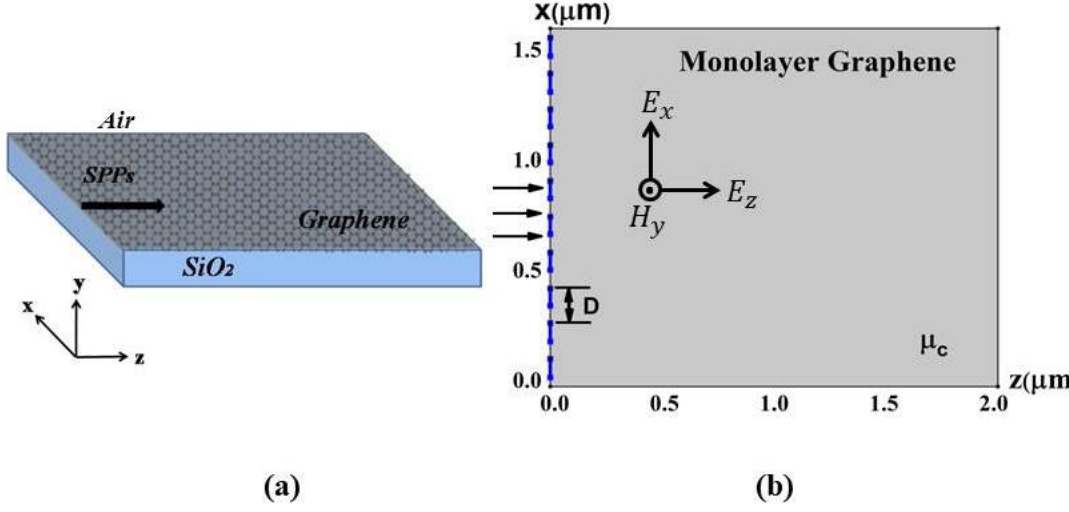
Figure 1. ( a ) The graphene sheet is surrounded by air with a dielectric constant ε 0 and placed on silicon dioxide substrate with a dielectric constant ε = 3.9. ( b ) The calculation window of the model structure of the plasmonic Talbot effect.